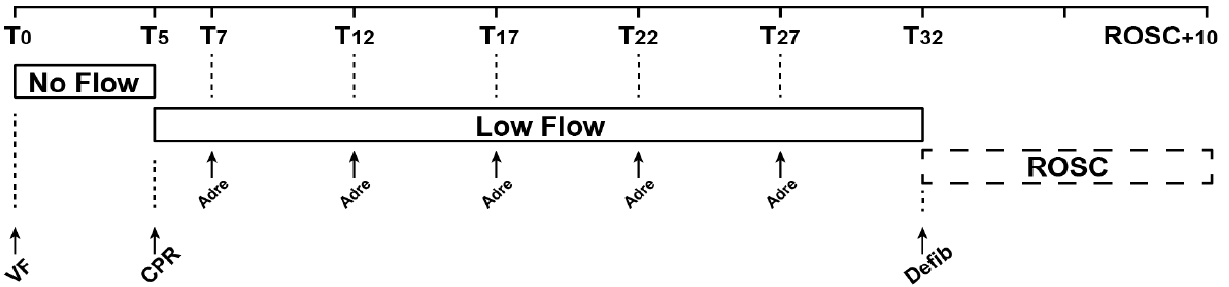
Figure 1. Experimental timeline. VF, ventricular fibrillation; CPR, cardio-pulmonary resuscitation; Adre, adrenaline injection; Defib, defibrillation.